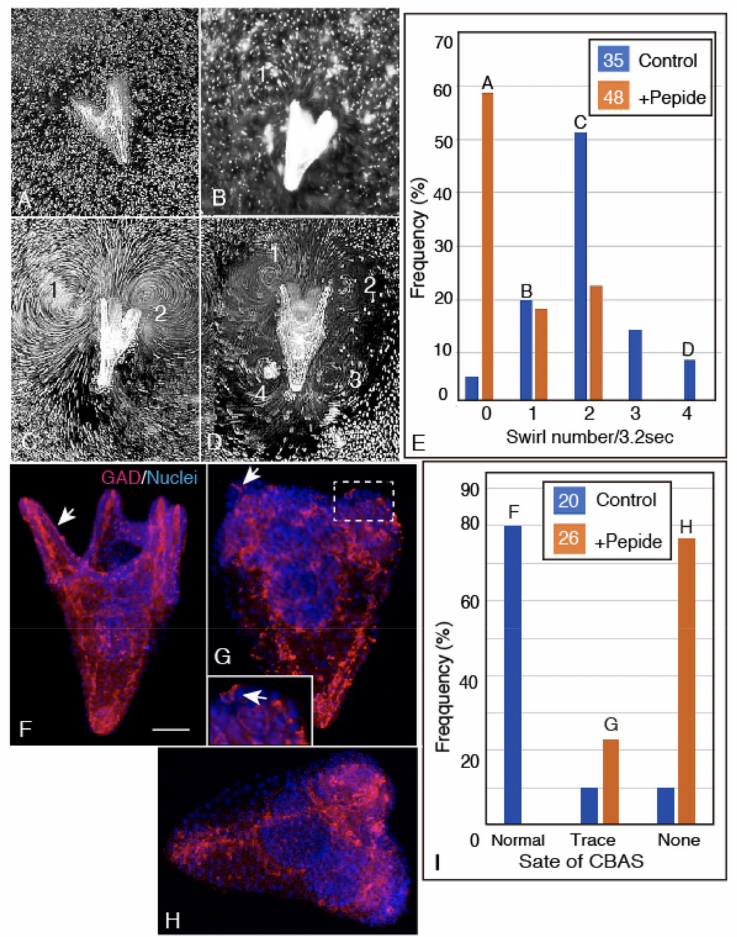
Figure 9. Application of Netrin peptide interferes with ciliary beating activity and CBAS patterning in 3dpf 4aPL. ( A ) A major proportion of the peptide-applied larvae formed no swirl (Column A in (E)). ( B ) A second major proportion of the control larvae formed one swirl (Column B in (E)). ( C ) A major proportion of control (Column C in (E)) and a distant second major proportion of peptide-applied larvae formed two swirls. ( D ) A small proportion of control larvae formed four swirls (Column-D in (E)). ( E ) The frequency of swirls in terms of group distribution was examined in 35 control larvae (blue columns) and 22 peptide-applied larvae (brown columns). Letters on the top of each column represent swirl patterns A–D. (F–I) Fluorescence microscopy of the whole-mount immunohistochemistry of 4aPL. ( F ) The major CBAS pattern of the control 4aPL acquired the clear poc (arrow). ( G ) A small proportion of the peptide-applied 4aPL formed CBAS composed only of a few GADCs insertions into the circumoral ectoderm (arrows, rectangle). Inset: enlarged rectangle area. ( H ) No CBAS was formed in the majority of peptide-applied larva. ( I ) The frequency of CBAS forms in the control larvae (blue columns, total 20 larvae) and in the peptide-applied larvae (brown columns, total 26 larvae). Letters on the top of columns represent the CBAS forms shown by the WMIHC images (F–H). Scale bar = 60 µ